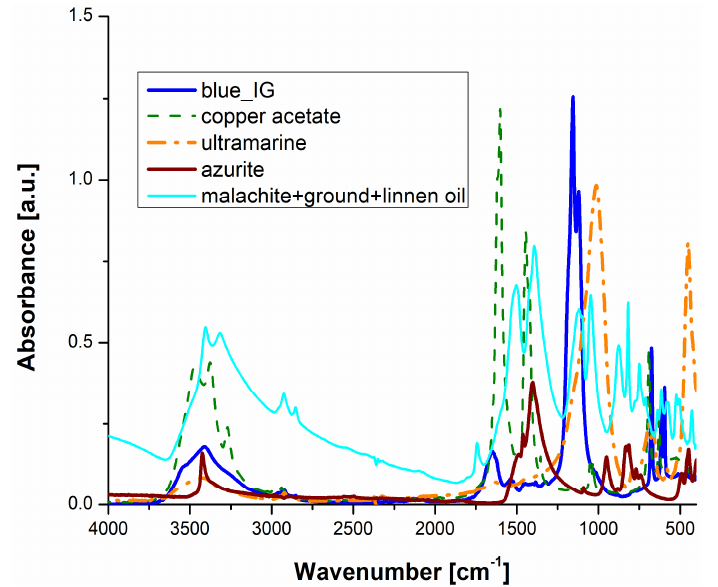
Figure 13. FTIR spectra of various blue and green painting materials, 4000 to 400 cm −1 spectral range.